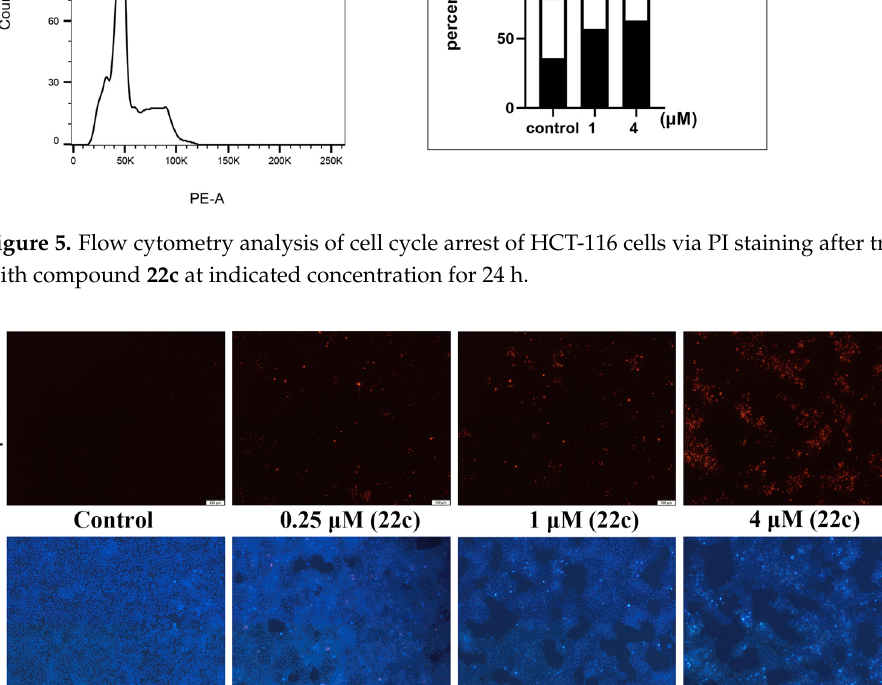
Figure 6. Analysis of the survival and apoptosis of HCT-116 cells induced by 22c via Hoechst 33342/PI staining. Normal cells show weak red fluorescence and weak blue fluorescence, while apoptotic cells show weak red fluorescence and strong blue fluorescence, the necrotic cells show strong red fluorescence and strong blue fluorescence .